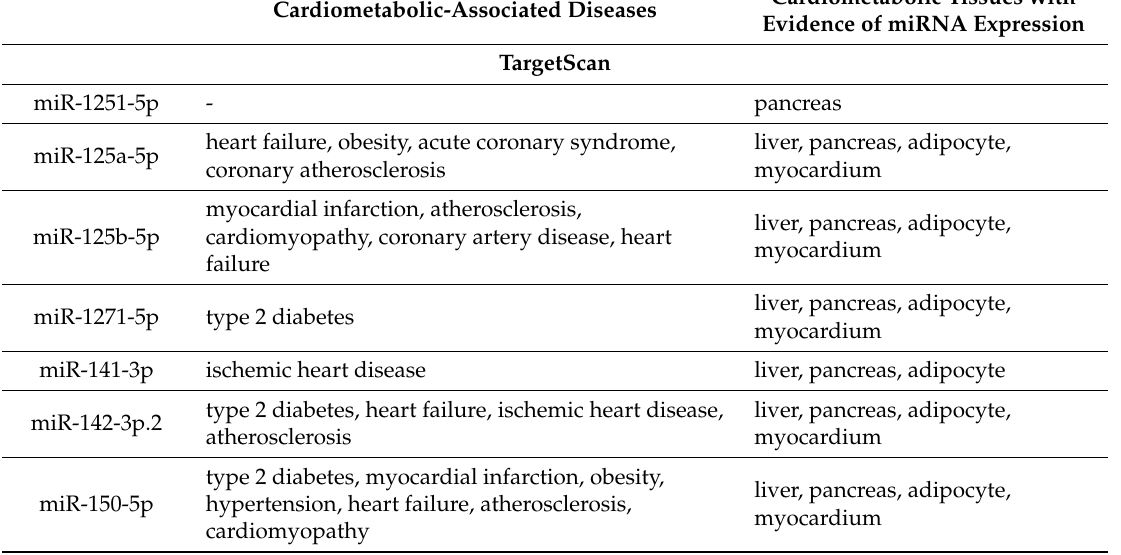
Table 3. Biological mechanisms associated with enriched